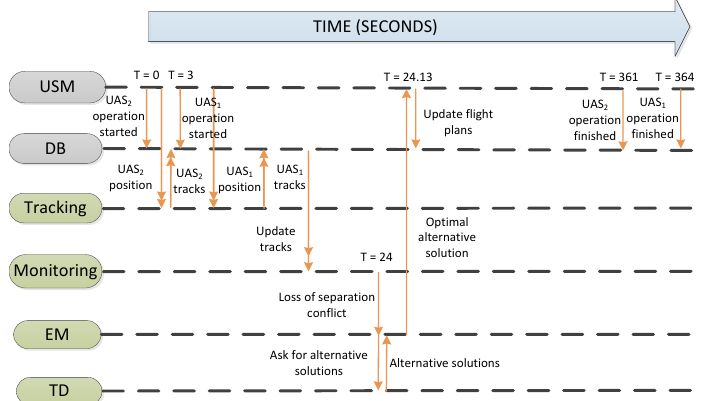
Figure 14. Timeline of the experiment of the use case 1, where a loss of separation event is resolved. Single arrows indicate isolated interactions between modules, whereas double arrows indicate periodic communication.